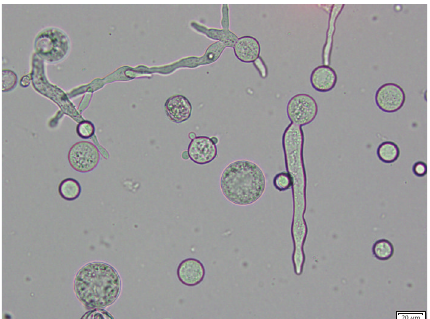
Figure 3: Mucor circinelloides yeast forms after cultivation of the isolate on Sabouraud dextrose agar incubated for 48 hrs under anaerobic conditions showing hyphae with single and multipolar buds (unstained,